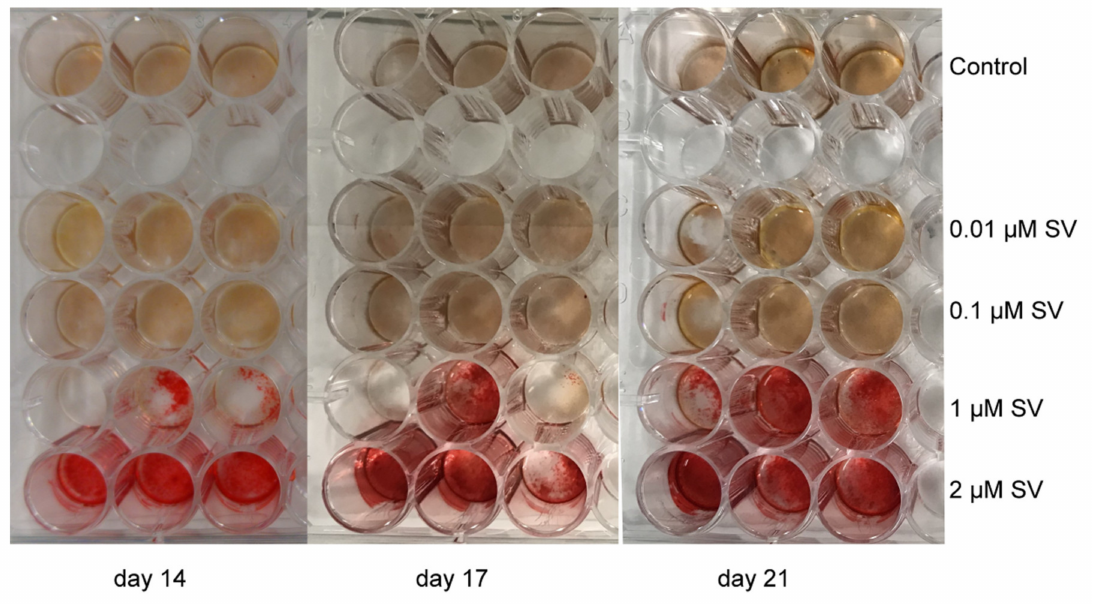
Figure 5. Alizarin S red staining prior to the dilution. From left to right ascending time in days; top row control and below the ascending concentrations as marked on the right